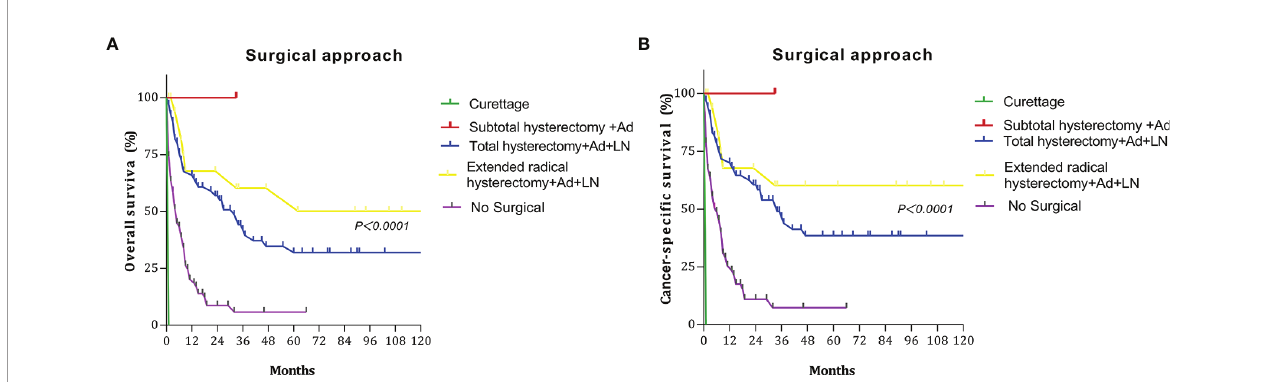
FIGURE 3 | Survival curves at different surgery type: (A) overall survival (OS); (B) cancer-speci fi c survival